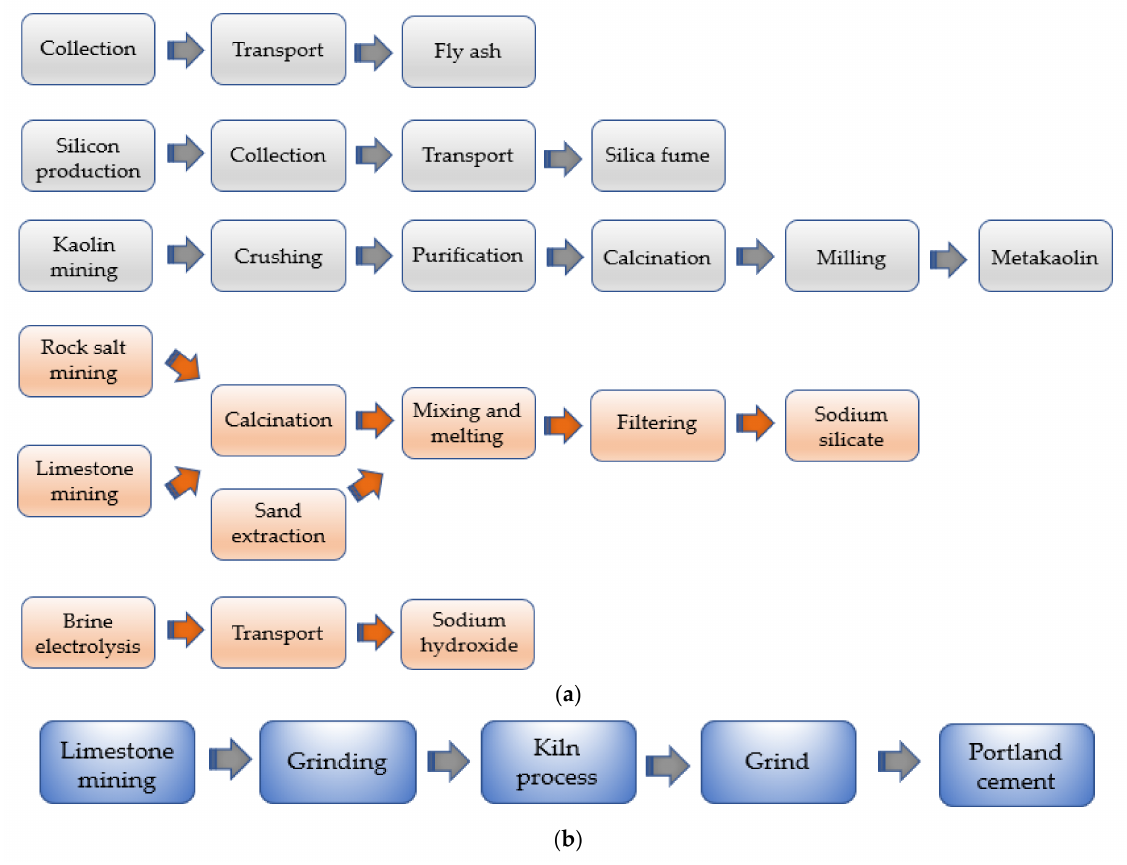
Figure 19. Schematic life cycle stages for production geopolymer ( a ) and Portland ( b ) cements